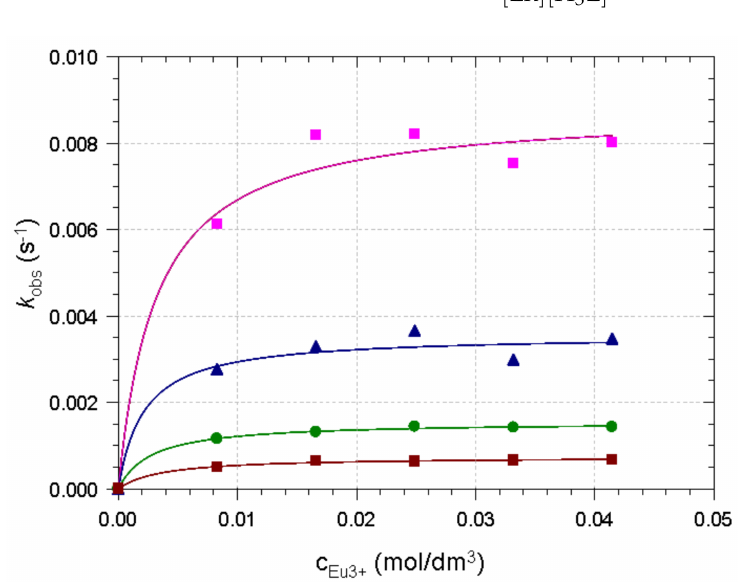
Figure 2. Pseudo-first-order rate constants (k obs ) as a function of the Eu 3+ concentration (c Eu3+ ) in the formation reaction of Eu(DO3A-ACE) − : pH = 5.41 ( (cid:4) ); 4.82 ( (cid:78) ); 5.11 ( • ); 4.51 ( (cid:4) ) (c L = 1.60 mM, 25 ◦ C: 0.15 M NaCl). The solid lines represent the simultaneous fit of the data at all pH values to Equation